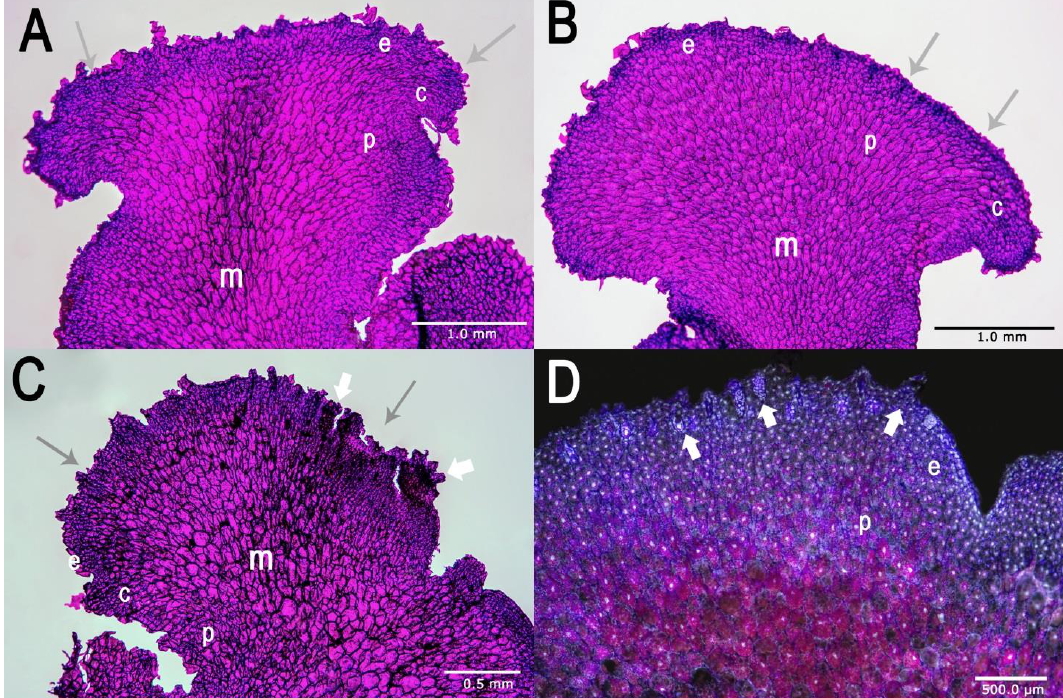
Figure 3. Light ( A – C ) and UV ( D ) micrographs of longitudinal sections of a different morphological type of Huperzia selago gametophytes. Picture shows an apical region of gametophytes with meristematic zones (arrows). Along the apical regions of some mature prothalli, clusters of gametangia were found ( C , D , small white arrows); e-epidermis, c-cortex, p-palisade cells, m-central parenchymatous core.